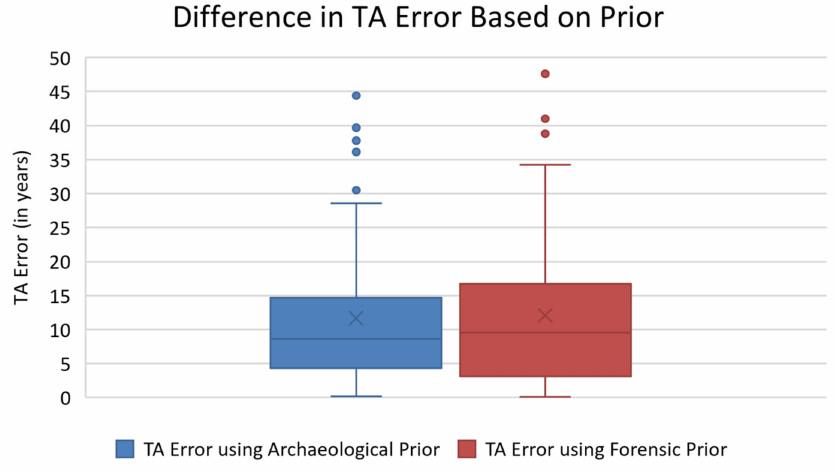
Figure 2. Difference in TA error (in years) between archaeological prior and forensic prior using a sub-sample from the Hamann–Todd